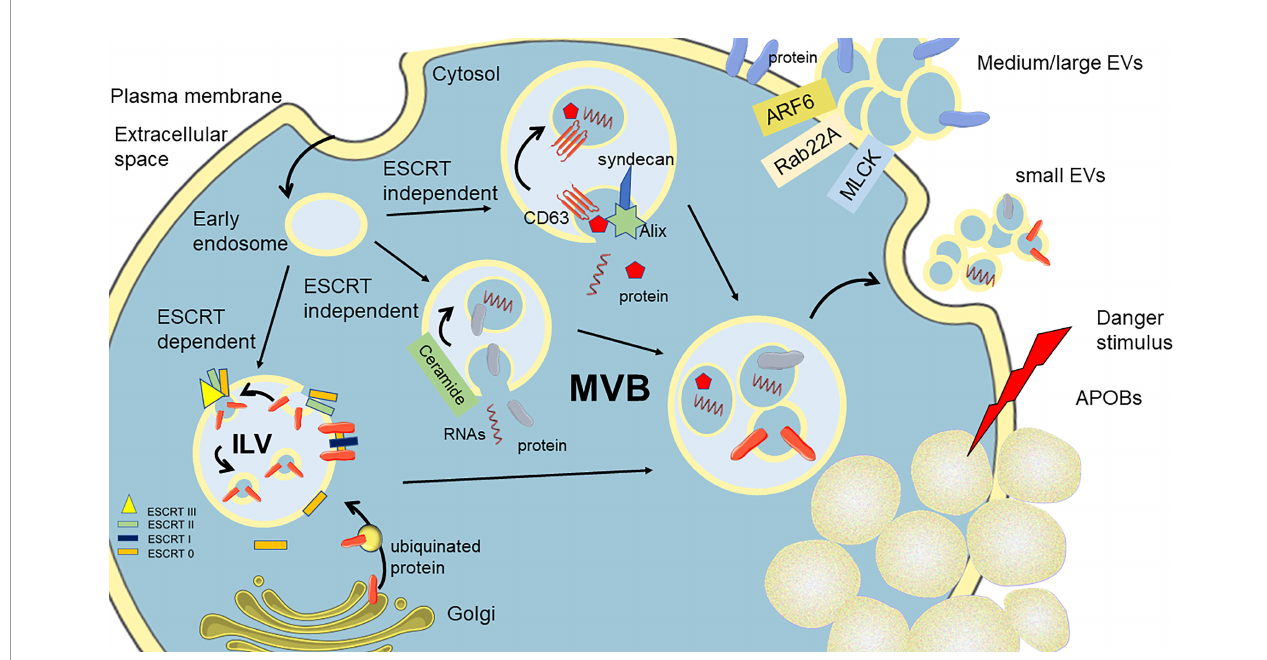
FIGURE 1 | Schematization of the biogenesis of the three classes of EVs. Small EVs arise from the shedding of MVBs fusing with the plasma membrane (PM). Three main paths are described for the formation of MVBs, entrapping in the cytoplasmatic components of ILVs. Medium and large EVs are derived for the budding of PM, pulling the constituent of PM. Apoptotic bodies (APOBs) are released after an irreversible injury to the cell, triggering apoptotic cell death and the perturbation of PM. MVBs, multivesicular bodies; ILVs, intraluminal vesicles; ESCRT, endosomal sorting complexes required for